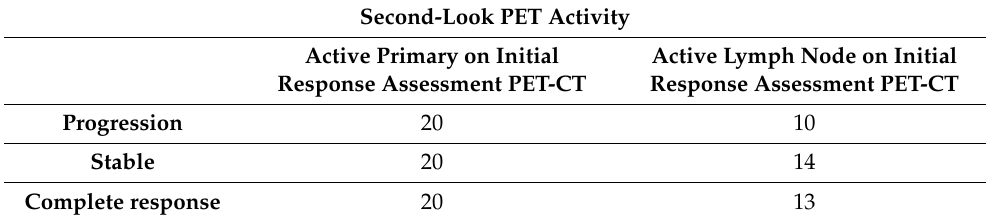
Table 3. Comparison of response categories between initial and second-look